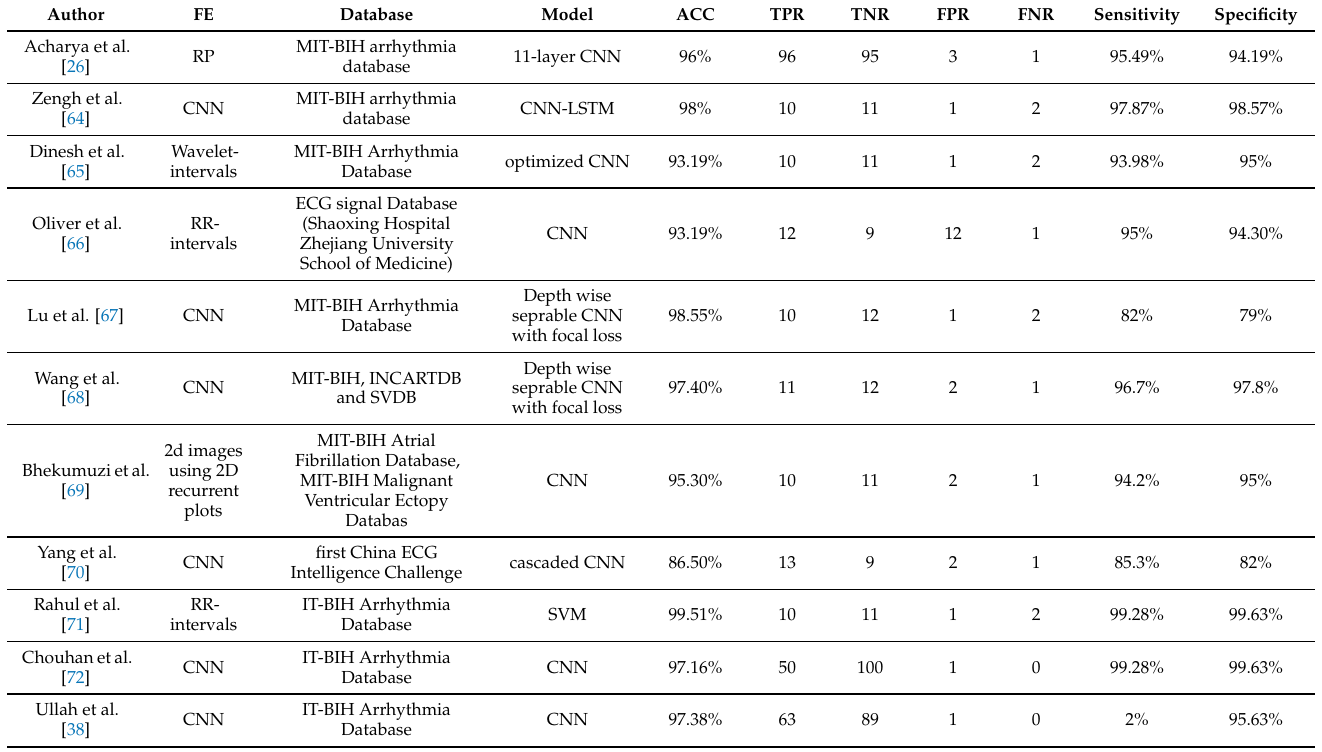
Table 8. Comparison table of the proposed architecture with some other existing architectures in terms of feature extraction (FE) methods, methodology, accuracy, and other statistical